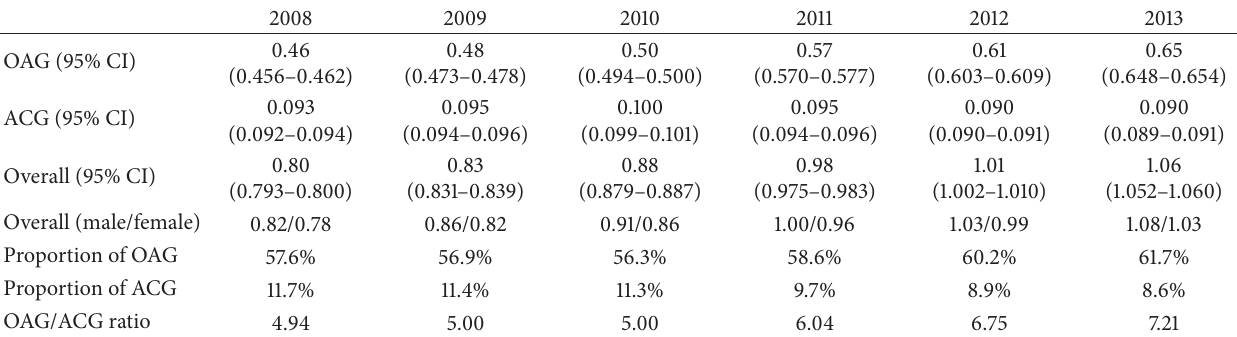
Table 2: Estimated prevalence (%) of glaucoma in Koreans over 40 years of age.